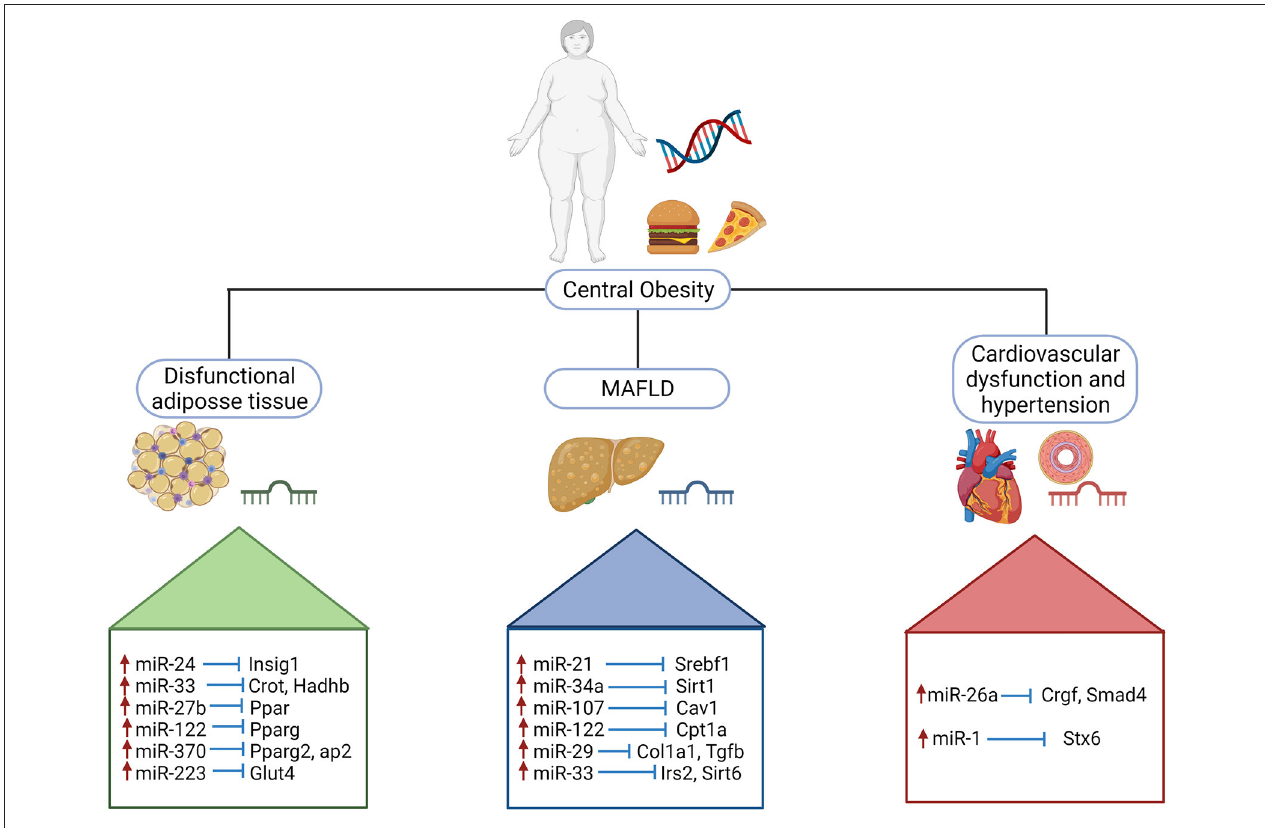
FIGURE 3 | Upregulated miRNAs involved in pathogenesis and development of MAFLD. Schematic illustration of selected miRNAs shows the impact on the stimulatory effect on target genes implicated in obesity, metabolic dysregulation and cardiovascular dysfunction. Insig 1, insulin induced gene 1; Crot, carnitine O-octanoyltransferase; Hadhb, hydroxyacyl-coa dehydrogenase trifunctional multienzyme complex subunit beta; Ppar, peroxisome proliferator activated receptor; Pparg, peroxisome proliferator activated receptor gamma; Pparg2, peroxisome proliferator activated receptor gamma 2; aP2, activating protein 2; Glut4, glucose transporter type 4; Srebf1, sterol regulatory element binding transcription factor; Sirt1; sirtuin 1; Cav1, caveolin 1; Cpt1a, carnitine palmitoyltransferase 1A; Col1a1, collagen type I alpha 1 chain; Tgfb, transforming growth factor beta; Irs2, insulin receptor substrate 2; Sirt6, sirtuin 6; Crgf, teratocarcinoma-derived growth factor 1; Smad4, SMAD Family Member 4; Stx6, syntaxin